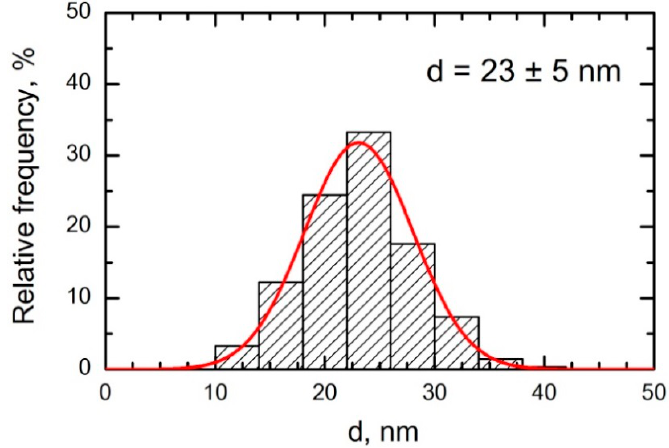
Figure 9. Particle or particle aggregate size distribution function obtained by statistical processing of 250 (N 0 ) measured SEM NPs images of particles accumulated on a polycarbonate filter from the exposed rats’ breathing zone.